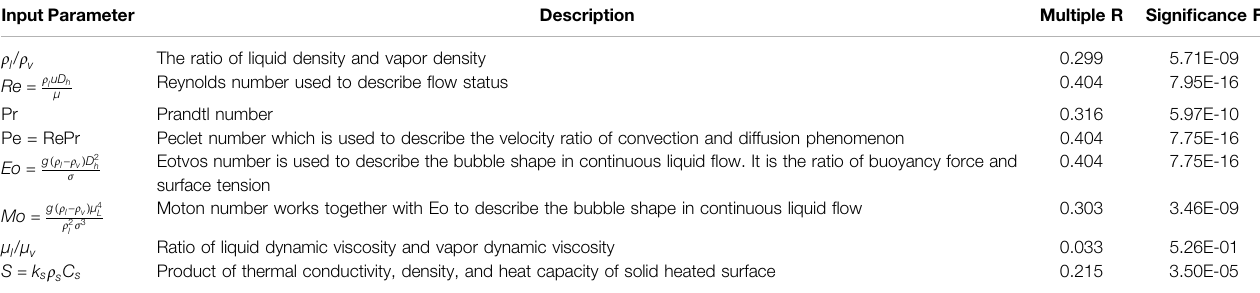
TABLE 2 | Relevance analysis of potential input parameters.